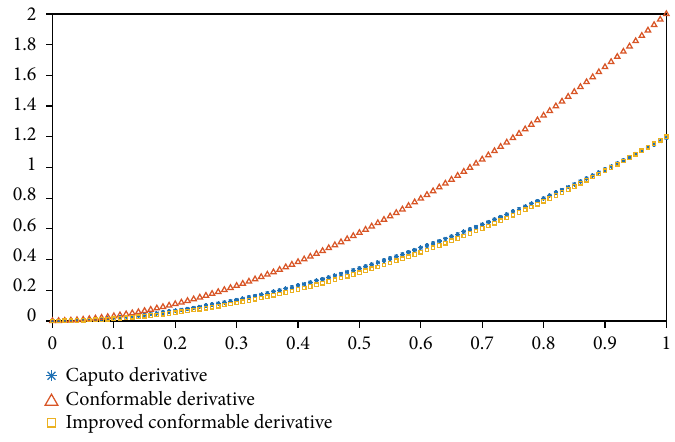
Figure 3: 0.2th fractional derivative of y = x 2